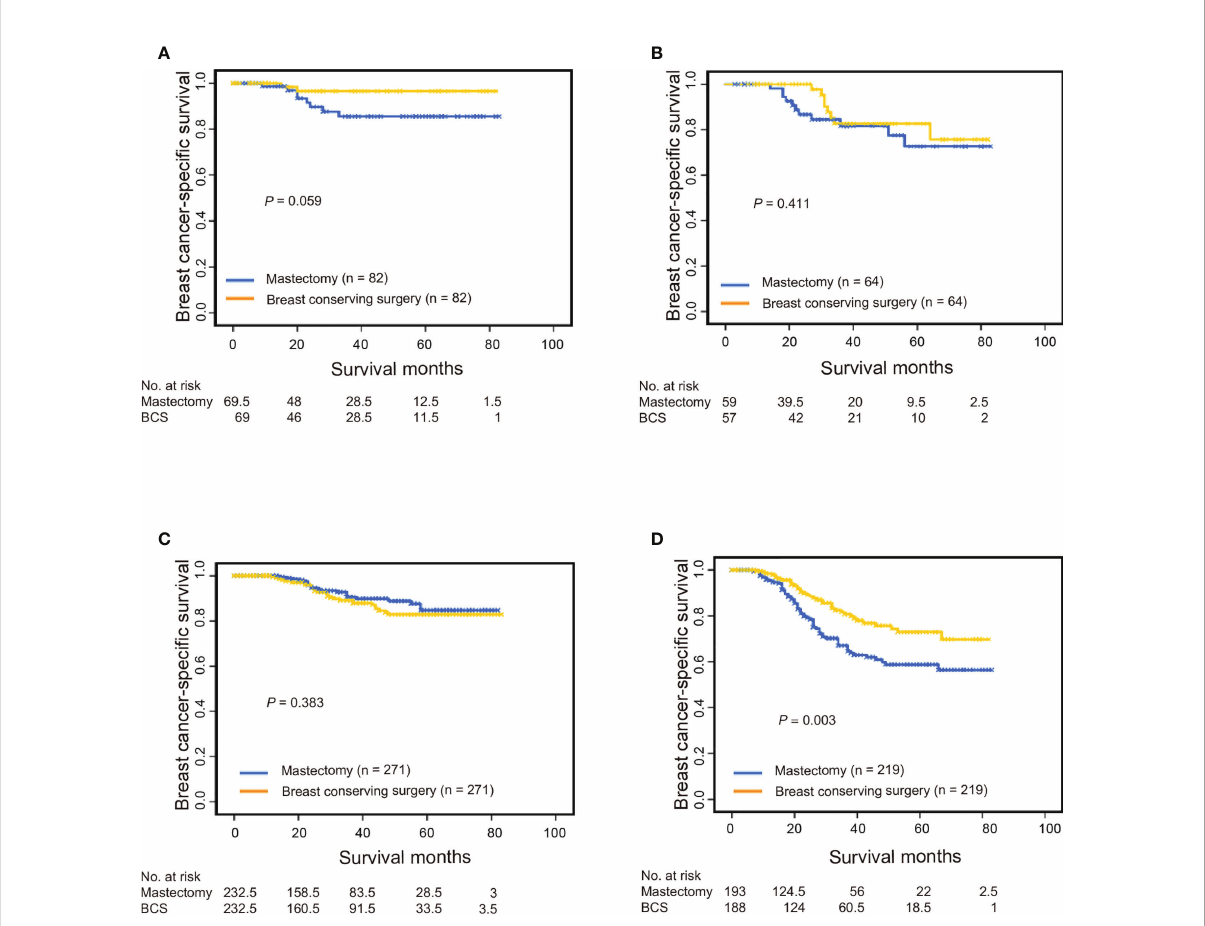
FIGURE 2 Breast cancer-speci fi c survival among propensity score-matched patients with triple-negative breast cancer who underwent breast conservation surgery versus mastectomy. (A) Patients with T1N0M0 stage, (B) patients with T1N+M0 stage, (C) patients with T2-4N0M0 stage, and (D) patients with T2-4N+M0 stage. BCS, breast-conserving